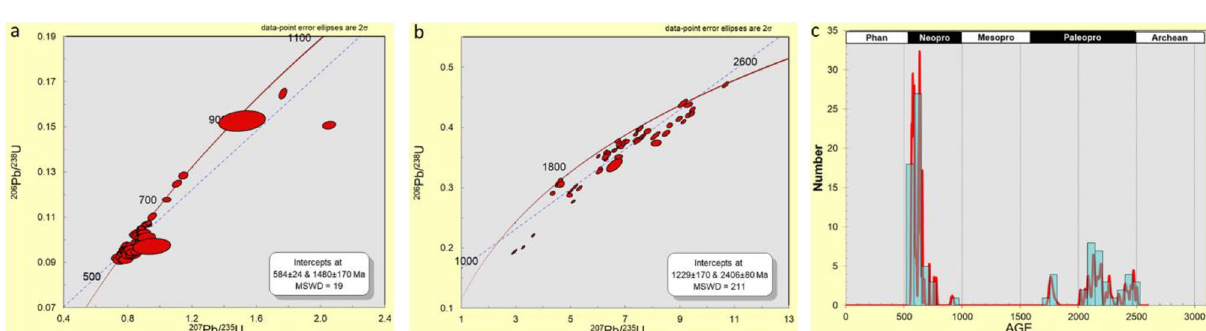
Figure 6. U–Pb concordia diagram of detrital zircon grains ( a ) Ages < 1300 Ma, ( b ) Ages > 1300 Ma, and ( c ) probability density diagram of detrital zircon ages with concordance between 90 and 110% in the studied Lakiri kaolins.